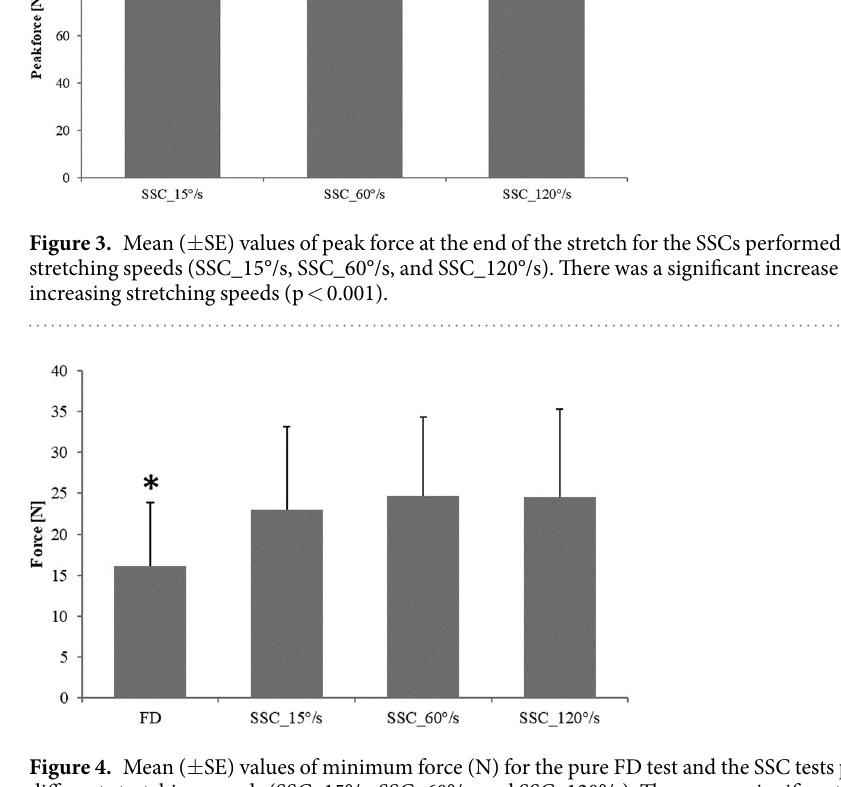
Figure 4. Mean ( ± SE) values of minimum force (N) for the pure FD test and the SSC tests performed at different stretching speeds (SSC_15°/s, SSC_60°/s, and SSC_120°/s). There was a significant difference in the minimum force for pure FD compared to all SSCs, but there was no significant difference across the SSCs. ( * Compared to SSCs; p <